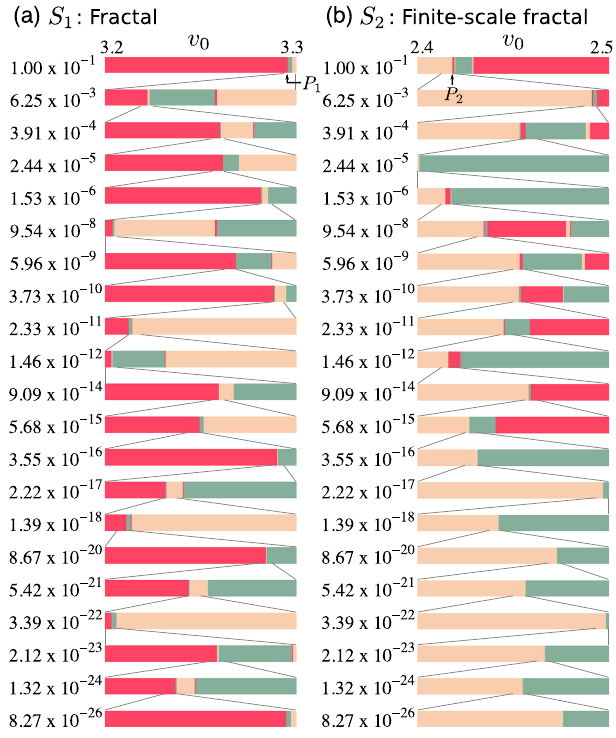
FIG. 5. Successive magnification of the attraction basins on vertical line segments through the points P 1 (a) and P 2 (b) in Figs. 4(a) and 4(b), respectively. The numbers on the left indicate the length of the magnified intervals. The details on the computa- tional procedure used to generate this figure can be found in Appendix D. FIG. 4. Slim fractal boundaries of the attraction basins for the roulette system. (a) – (c) Attraction basins for the roulette shapes shown in Fig. 3 in the two-dimensional subspace parametrized by the initial condition ð v 0 ; θ 0 Þ . The red, green, and beige regions indicate the basins of the attractors A 1 , A 2 , and A 3 (marked in Fig. 3), respectively. (d) – (f) Spatial distribution of the (color- coded) fractality length scale l ð v 0 ; θ 0 Þ on the boundaries of the basins shown in (a) – (c). Note that v 0 and θ 0 are normalized by v max and 2 π = 3 , respectively, only for the axes of the plots and not for the computation of l ð v 0 ; θ 0 Þ . We compute l ð v 0 ; θ 0 Þ using double precision and the bisection resolution of 10 − 13 for each of the 1024 × 1024 grid points [corresponding to Δ ¼ 2 − 10 v θ 3 . 38 × 10 − 3 to 6 . 48 × 10 − 3 0 Þ , which ranges from max ð depending on θ 0 and the roulette